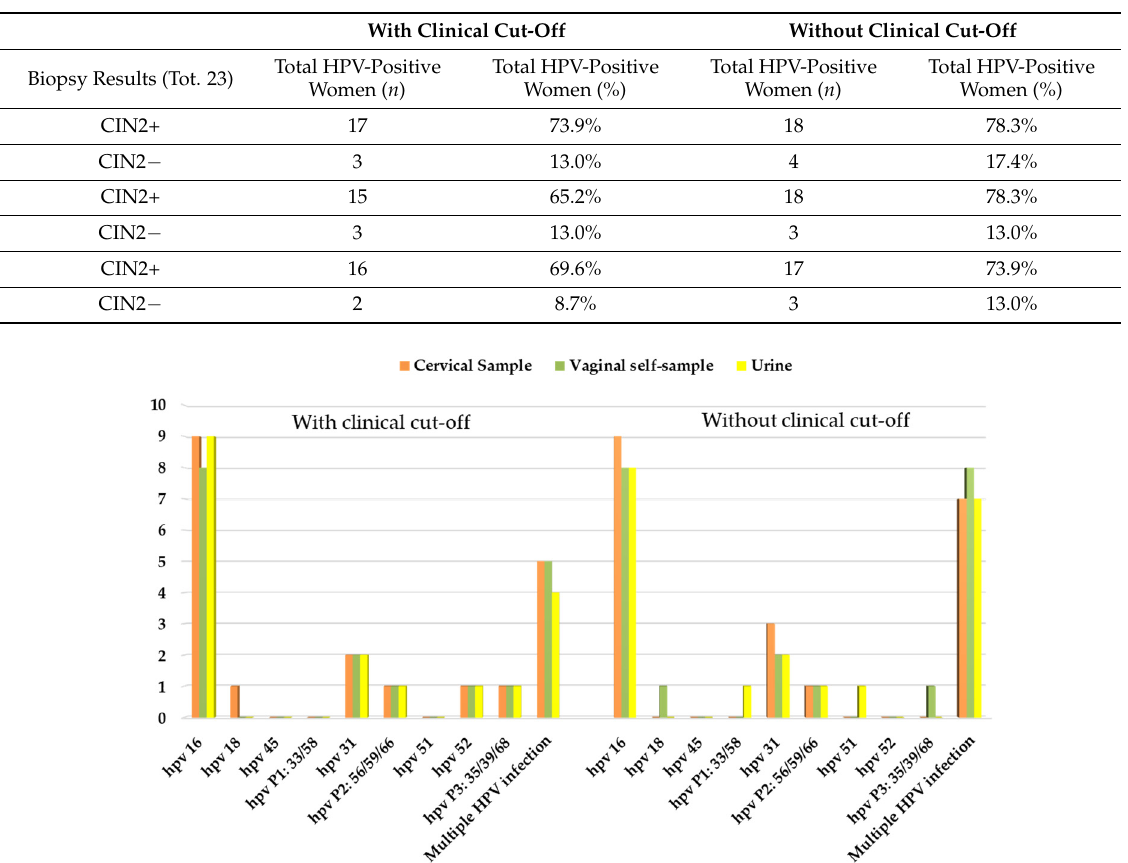
Table 4. HPV-positive women related to biopsy results.